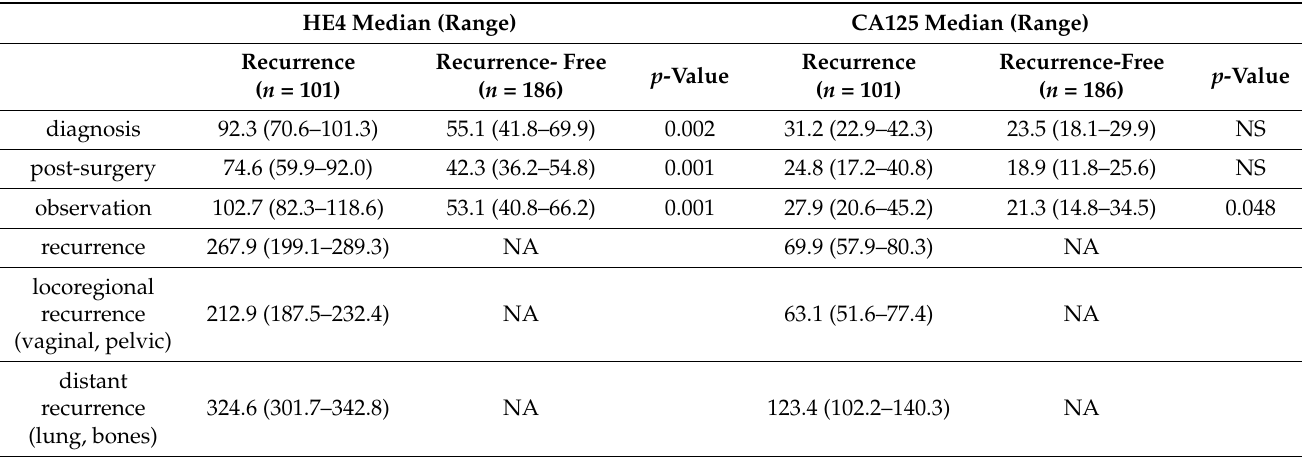
Table 4. HE4 and CA125 serum concentration according to recurrence or nonrecurrence of the